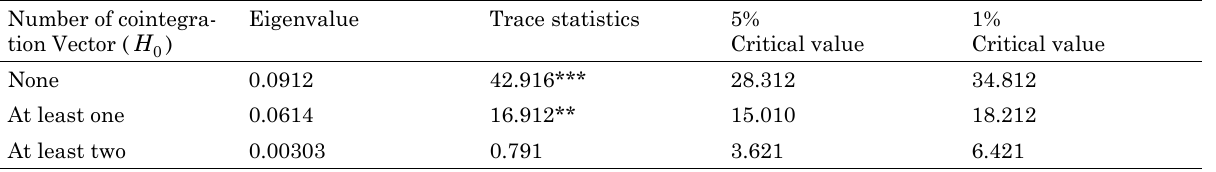
Table 4. Johansen cointeragtion vector and trace test Number of cointegra- tion Vector ( 0 H